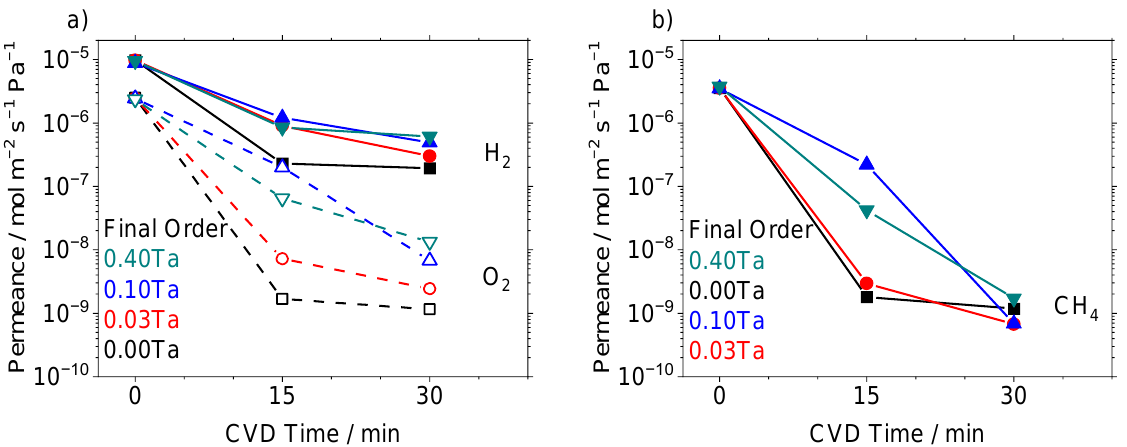
Figure 5. ( a ) Permeance of H 2 and O 2 vs. CVD time at 650 °C for the various Si/Ta precursor ratios. ( b ) Permeance of CH 4 vs CVD time at 650 °C for the various Si/Ta precursor ratios. Legend: Si-650 [ ( b ) Permeance of CH 4 vs CVD time at 650 ◦ C for the various Si/Ta precursor ratios. Legend: Si-650 Figure 4. Permeance of several gases at 650 °C after CVD for various Si/Ta precursor ratios: Si-650 [ Figure 4. Permeance of several gases at 650 °C after CVD for various Si/Ta precursor ratios: Si-650 [ Figure 4. Permeance of several gases at 650 °C after CVD for various Si/Ta precursor ratios: Si-650 [ Figure 4. Permeance of several gases at 650 °C after CVD for various Si/Ta precursor ratios: Si-650 [ ■ ], Si-3Ta-650 [ ● ], Si-10Ta-650 [ ▲ ], Si-40Ta-650 [ ▼ ]. ■ ], Si-3Ta-650 [ ● ], Si-10Ta-650 [ ▲ ], Si-40Ta-650 [ ▼ ]. ■ ], Si-3Ta-650 [ ● ], Si-10Ta-650 [ ▲ ], Si-40Ta-650 [ ▼ ]. ■ ], Si-3Ta-650 [ ● ], Si-10Ta-650 [ ▲ ], Si-40Ta-650 [ ▼ ]. ■ ], Si-3Ta-650 [ ● ], Si-10Ta-650 [ ▲ ], Si-40Ta-650 [ ▼ ]. [ One potential explanation for the increase in pore size control and enhancement in selectivity for O 2 , N 2 and CH 4 gases is that the addition of TaEO resulted in a slower dep-